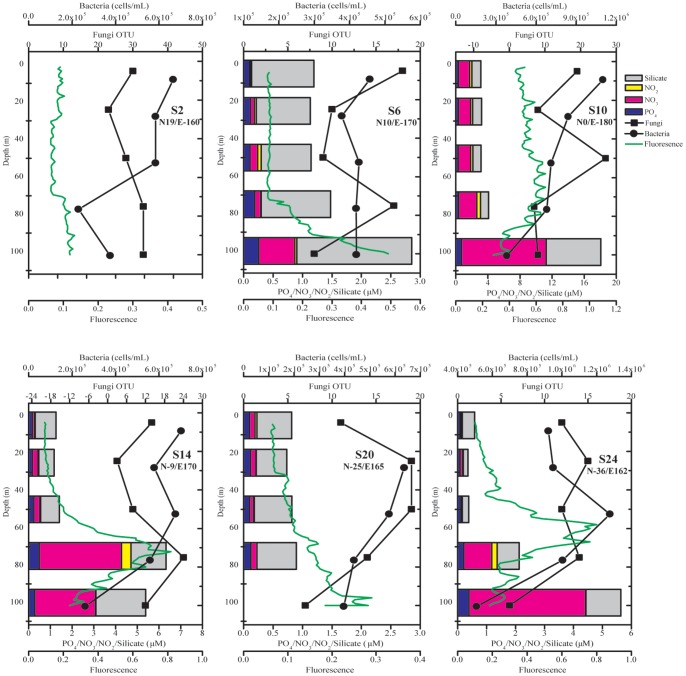
Marine fungal diversity along sampling stations.Fungal OTU number at various depths of each sampling station was plotted along with other biotic and abiotic factors. Fungal OTU (filled square), bacteria (filled circle), and chlorophyll (green line) were plotted against the sampling depths. At each depth, various nutrients including PO4-, NO3-, NO2- and Silicic acid were indicated as colored bars.